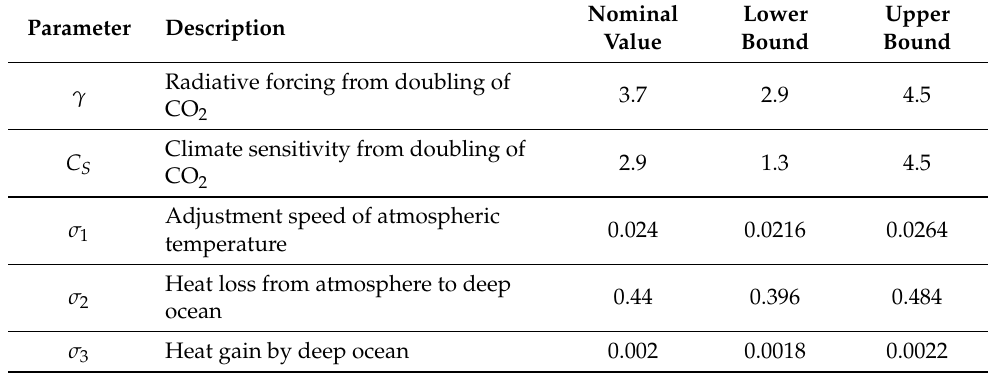
Nominal Lower Upper Value Bound Bound 3.7 2.9 4.5 2.9 1.3 4.5 0.024 0.0216 0.0264